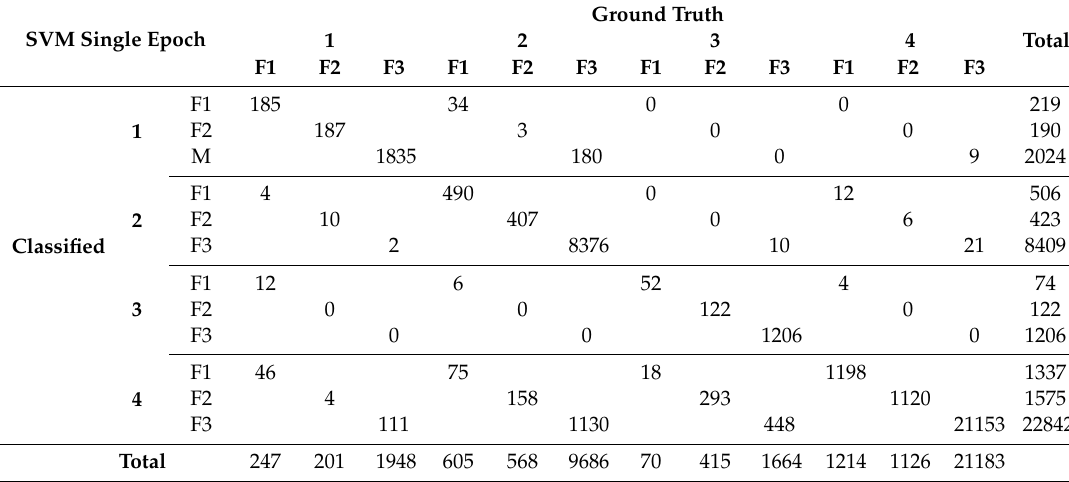
Table A3. Confusion matrix of single epoch classification performed with the Random Forest (RF) classifier. F1 - farm 1, F2 - farm 2 and F3 - farm 3. RF Single